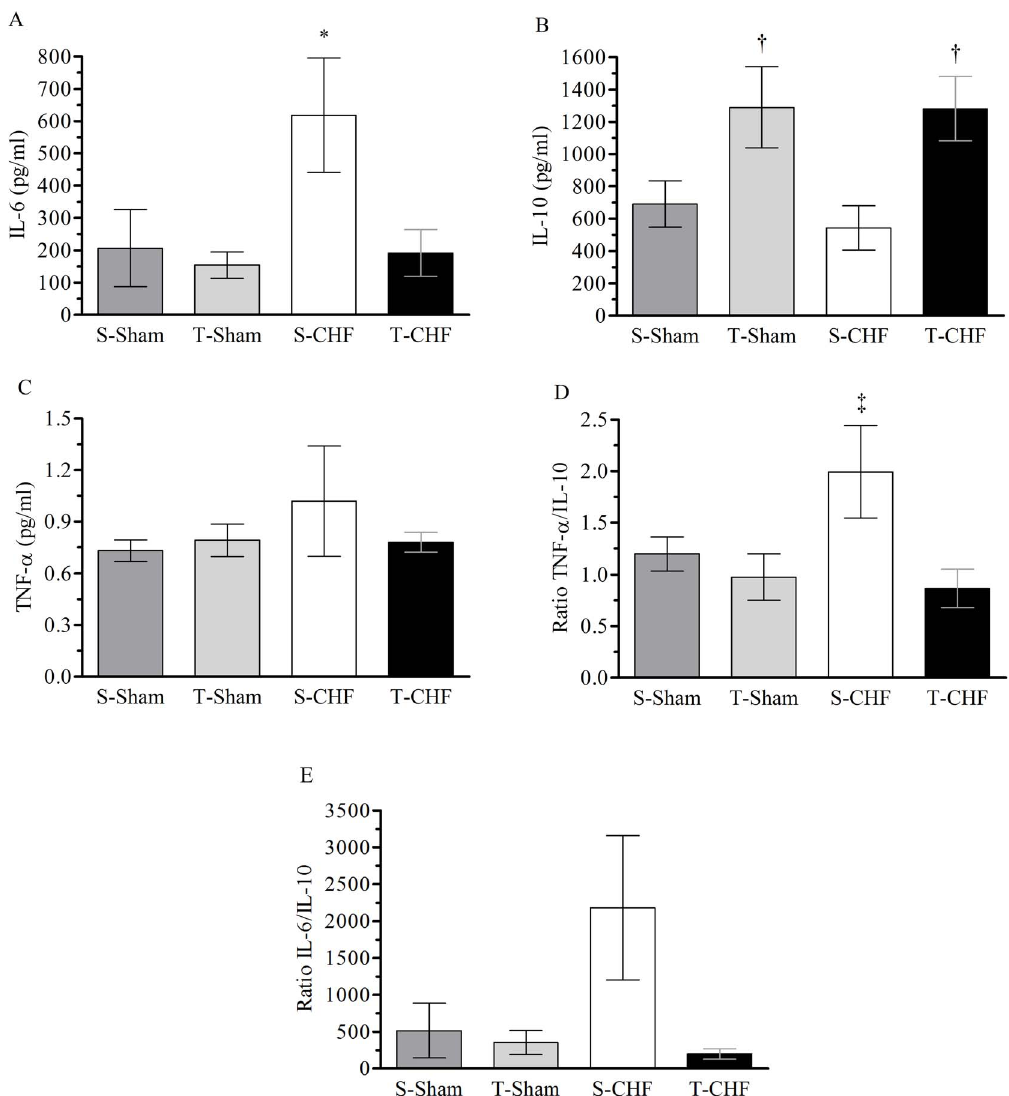
Figure 4. Plasma levels of IL-6, IL-10, TNF- a , TNF- a to IL-10 ratio and IL-6 to IL-10 ratio (A–E). Values are means 6 SE. Figure A) S-Sham, sedentary sham rats (n=5); T-Sham, training sham rats (n=5); S-CHF, sedentary chronic heart failure rats (n=5); T-CHF, training chronic heart failure rats (n=6). Figure B, C and D, n=6 for all groups. Figure E, n=5 for all groups. * P , 0.05 compared to all groups. { P , 0.05 compared to sedentary groups. ` P , 0.05 compared to trained